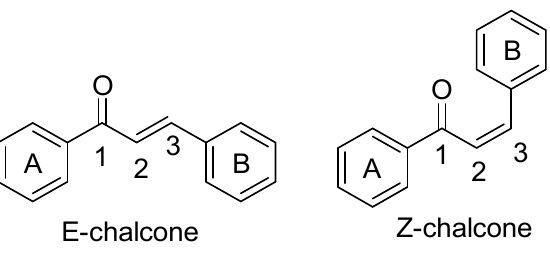
Figure 1. Chalcone structure and stereochemistry.